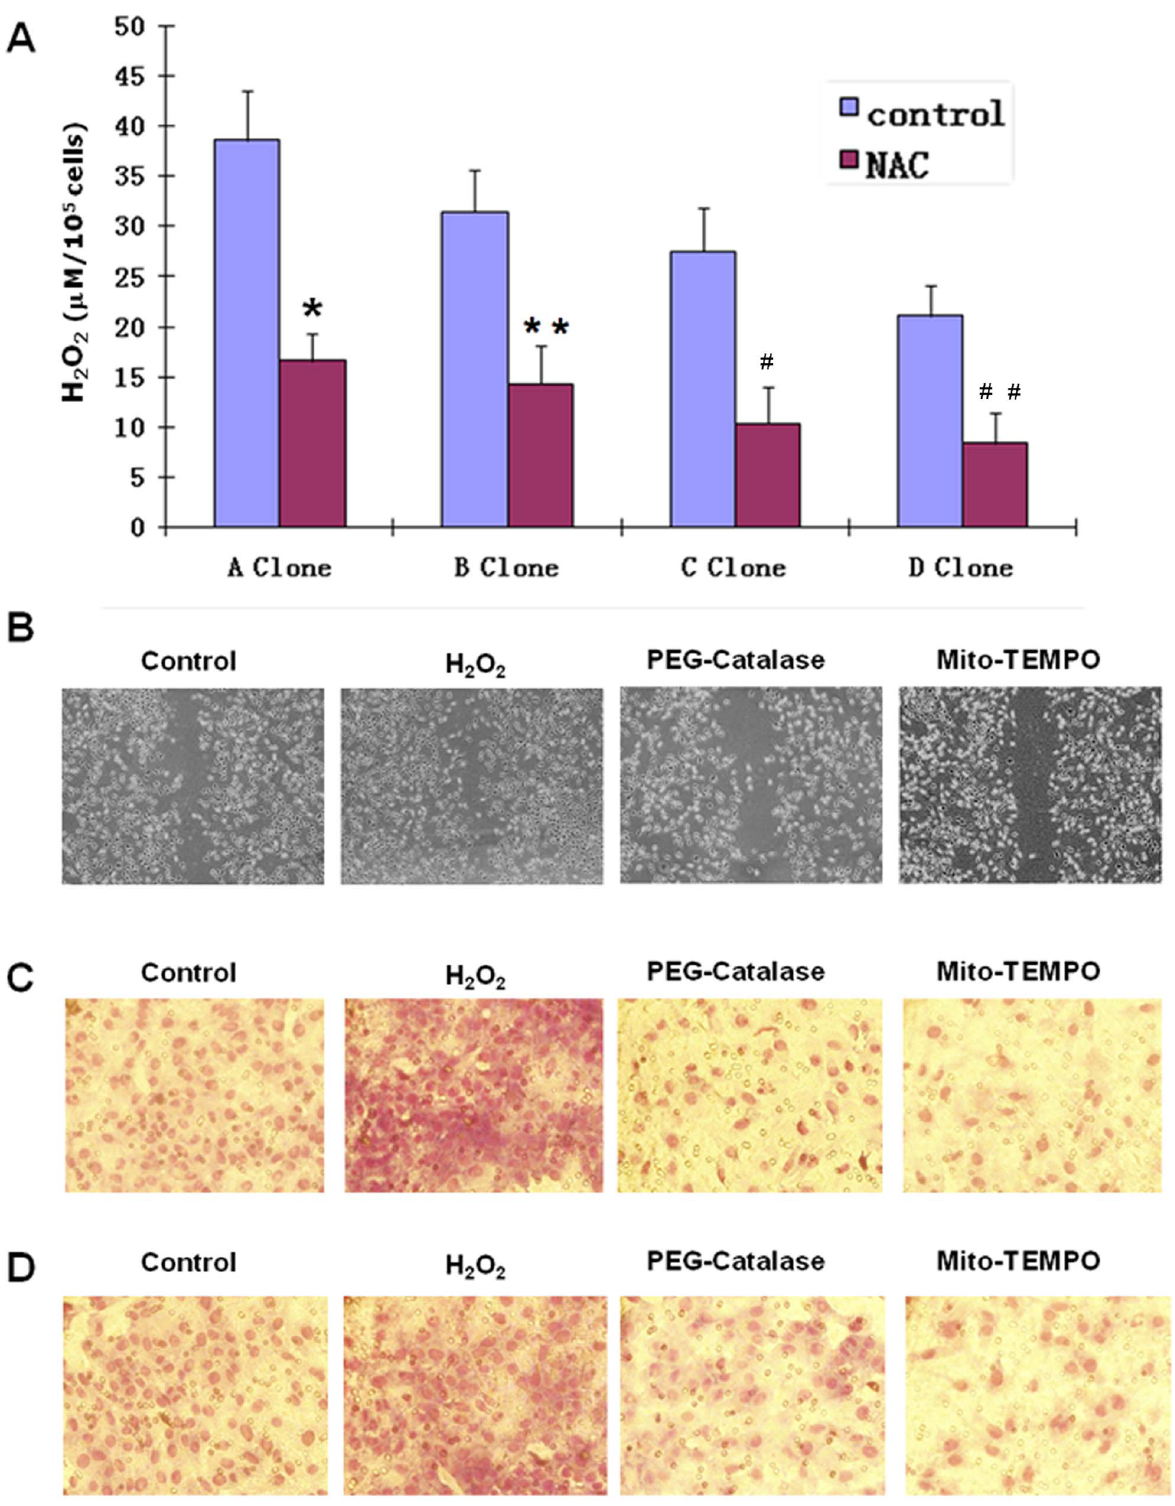
Figure 4. PEG-catalase and mito-TEMPO inhibited migration and invasion in subclone cells. A, The H 2 O 2 concentrations were measured in subclone cells treated with NAC. *P , 0.01 vs control in A clone, **P , 0.01 vs control in B clone, # P , 0.01 vs control in C clone, ## P , 0.05 vs control in D clones (n=3). B, Wound healing assay was conducted to measure the migration capacity of A subclone cells treated with 100 m M H 2 O 2 , 200 units/ml PEG-catalase, 25 nM mito-TEMPO, respectively. Images were captured at 24 h after wounding. C, Migration assay was performed in A subclone cells treated with indicated reagents. D, Invasion capacity of A subclone cells treated with indicated reagents was detected by transwell assay.